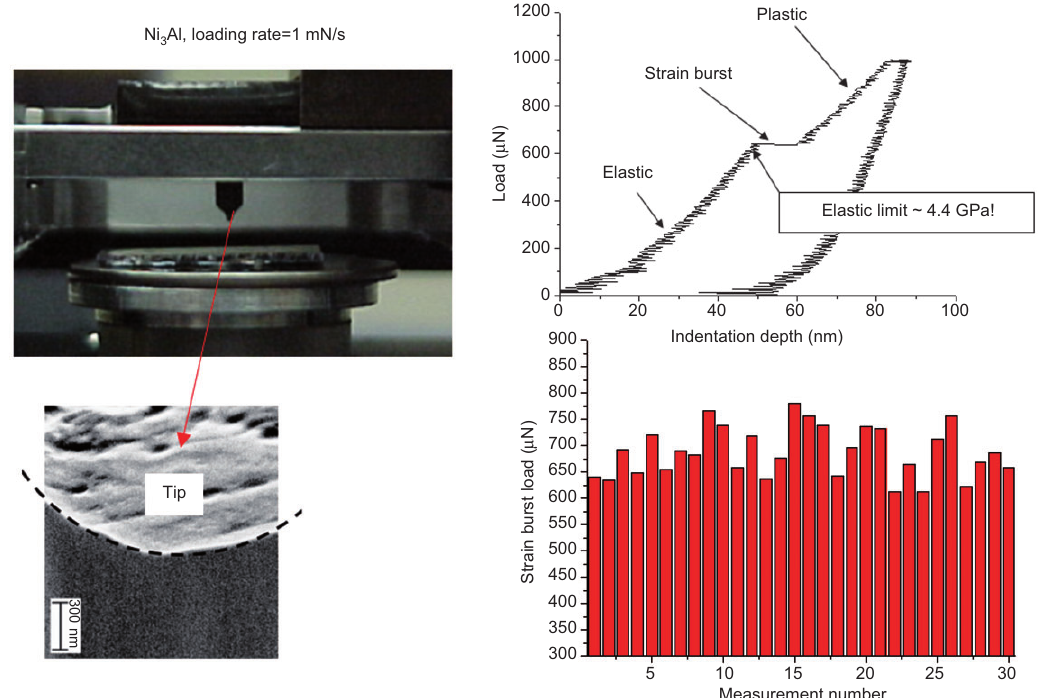
Figure 1 Sharp yield point observed during nanoindentation of well-annealed Ni